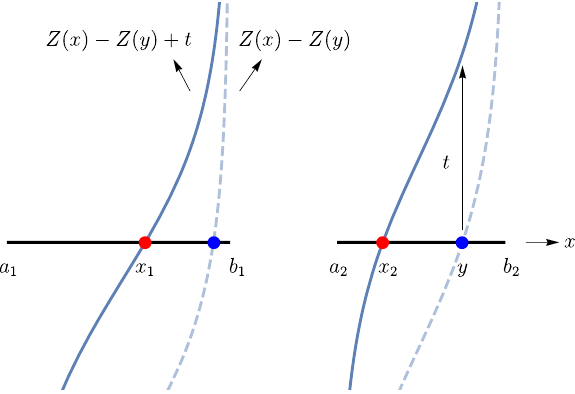
(cid:0) (cid:1) Figure 4 . An illustration of the modular flow σ t ψ † ( y ) in (3.15) for the union of two intervals ( a 1 , b 1 ) ∪ ( a 2 , b 2 ) (black) on the plane. We plot the function Z ( x ) − Z ( y )+ t for fixed y as a function of x , for both t = 0 (dashed curve) and t > 0 (solid curve). The zeroes of the function correspond to the dots (blue for t = 0 , red for t > 0 ). The flow couples the solutions of (3.14), Z ( x ) − Z ( y )+ t = 0 , which correspond to the zeroes of the function. Since Z ( x ) increases monotonically from −∞ to ∞ within each interval, there exists exactly one solution per interval. As modular time evolves, the curve is shifted linearly in time. Consequently the zeroes move left along modular flow. The solution contained in the same interval as y is the ‘local’ solution, while the other corresponds to the ‘non-local’